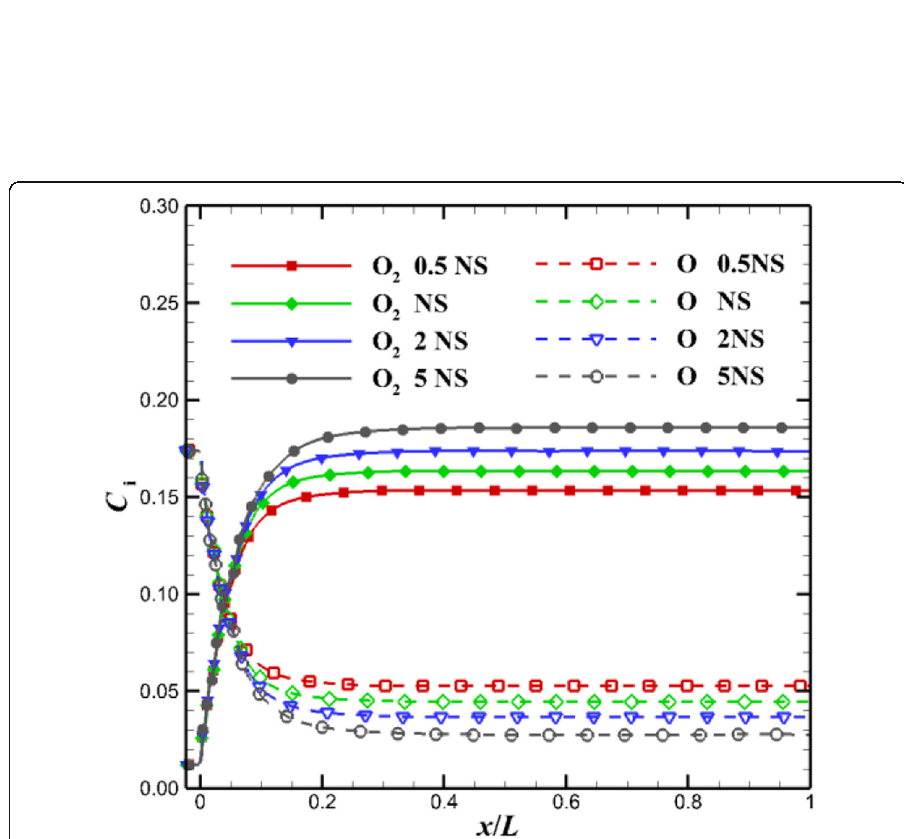
Fig. 14 Comparison of the centerline O 2 and O mass fraction distribution based on the HEG